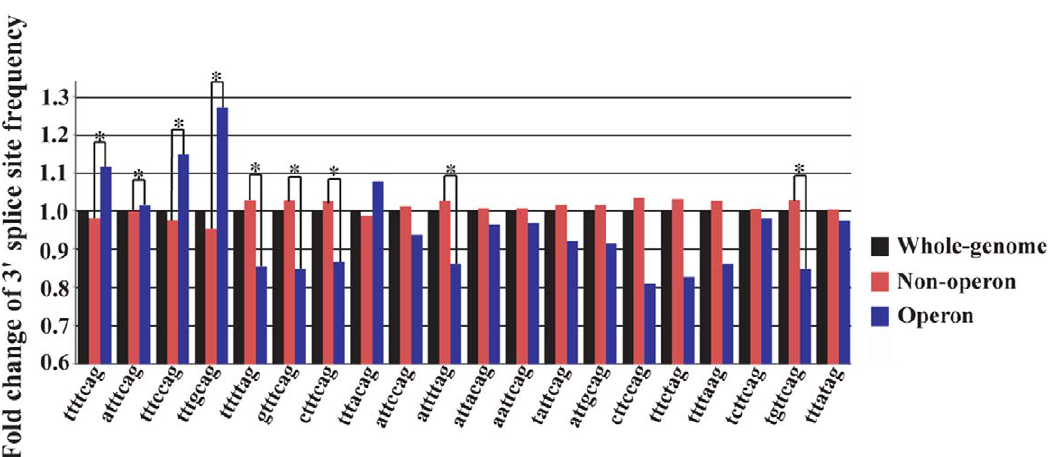
Figure 2. Common 3 9 splice sites are used differentially by C.elegans operonic genes. The proportions of each 3 9 splice site (X axis) of operonic and non-operonic genes were compared to that of all genes of the whole genome and were presented as fold changes (Y axis). Pairwise Z- test was performed (see Table 2) to evaluate the significance of difference between the proportions of each 3 9 splice site in operonic genes and non- operonic genes. *: p #